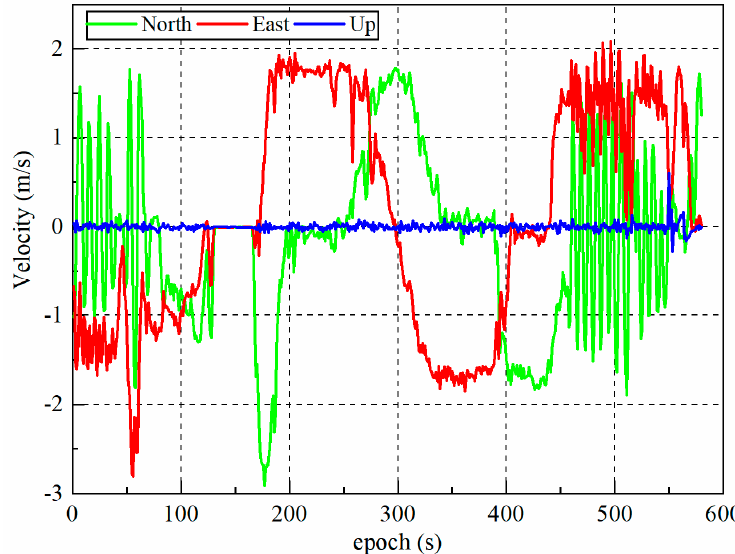
Figure 3. The driving velocity of the trolley in different directions.